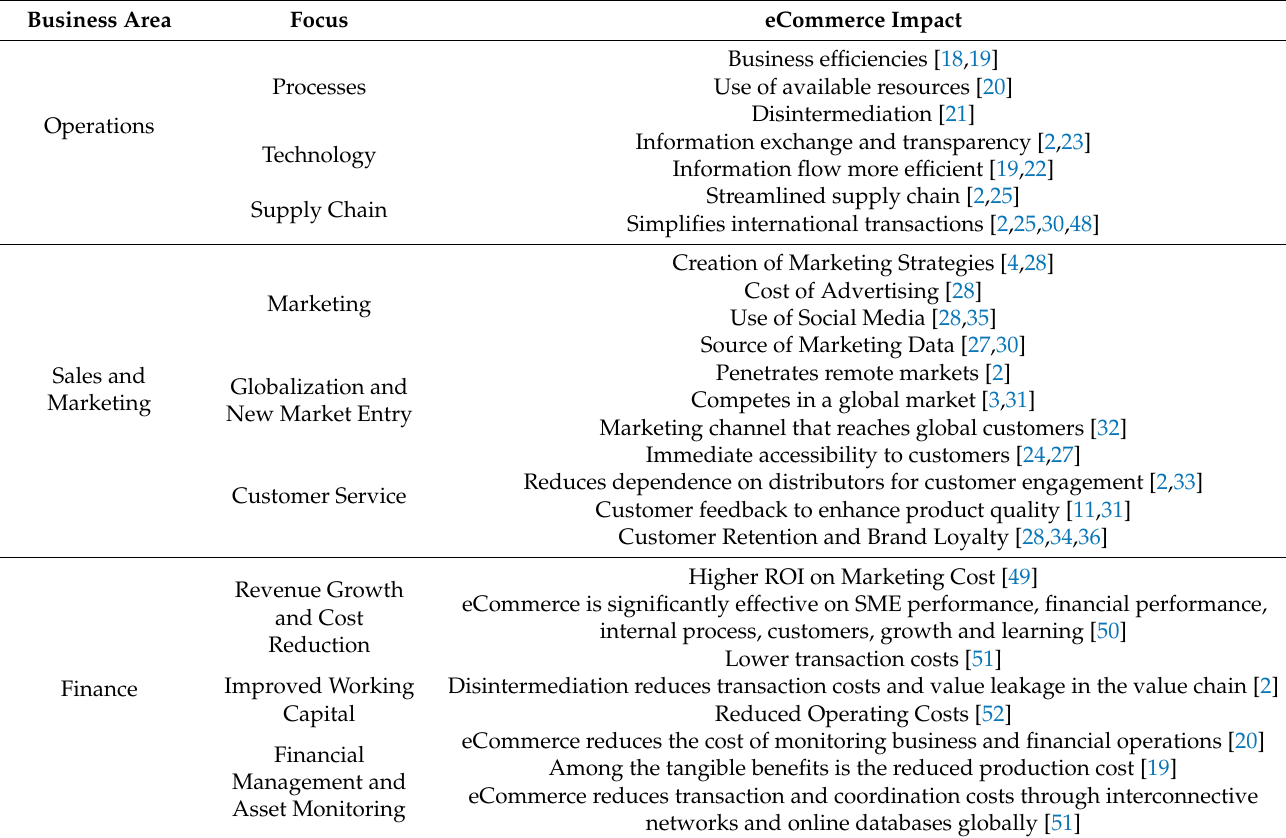
Table A1. Business area, focus, and impact of eCommerce on